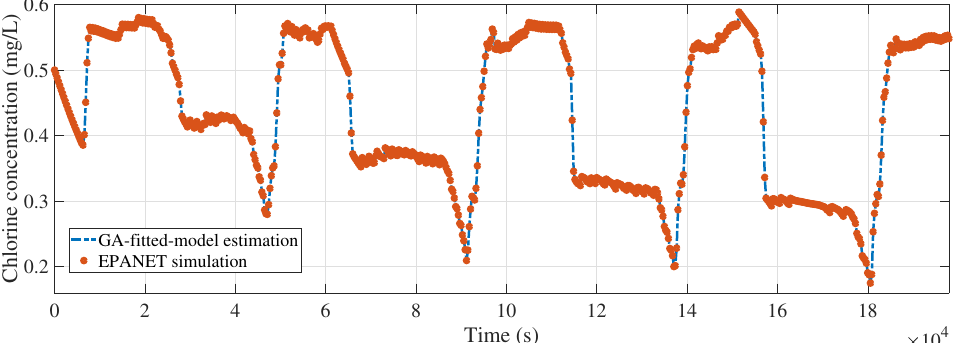
Figure 8. Calibrated model fitting for node 15 (rmse = 2.7089 × 10 − 4